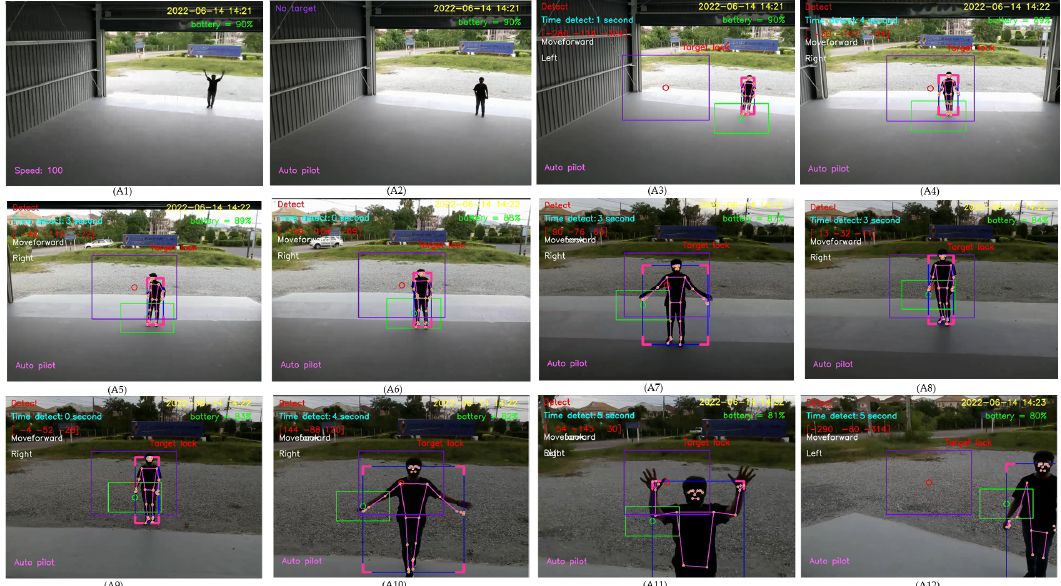
Figure 34. Sampling frames 1–30 of automatic tracking human